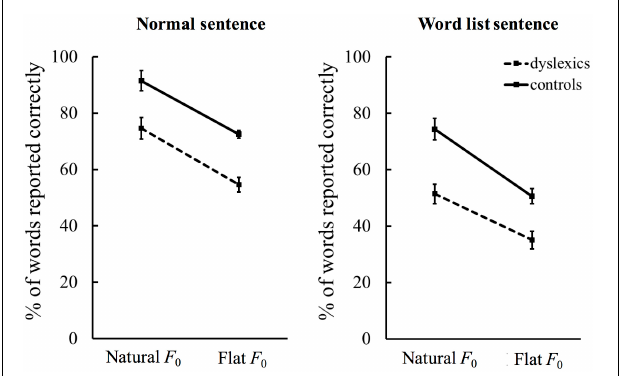
FIGURE 2 | Word-report accuracies of the simple interaction effects carried out on the significant three-way interaction between group, semantic context, and F 0 contours. Error bars represent standard